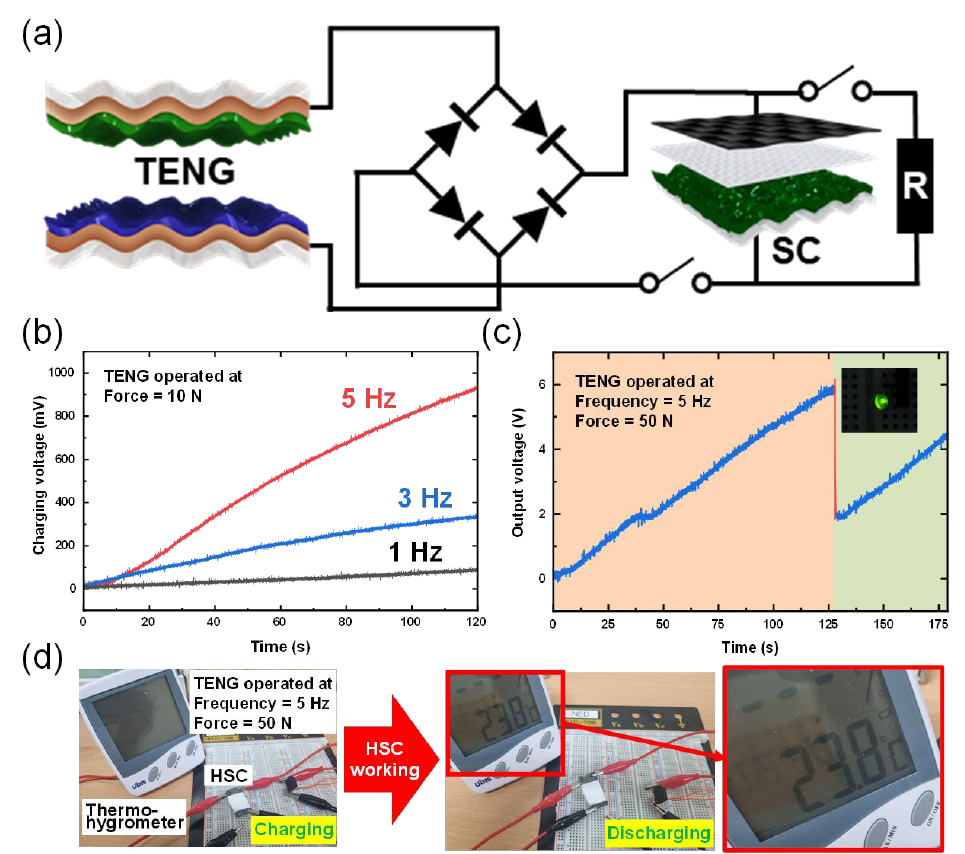
Figure 5. ( a ) Circuit diagram of energy generate and energy storage system. ( b ) The charging efficiency under various input frequencies (form 1 Hz to 5 Hz) of W-TENG. ( c ) The demonstration of the feasible application by lighting-up a commercial LED. ( d ) Real-time operation of the thermo-hygrometer using the hybrid energy system.